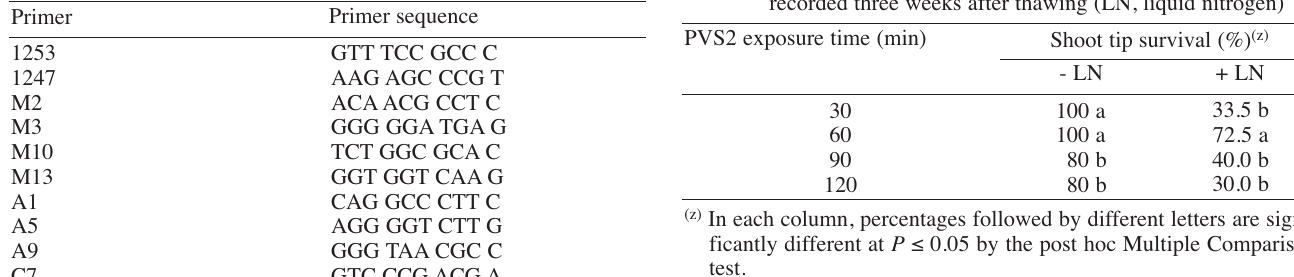
Table 2 - Survival of cryopreserved shoot tips of ‘Rosso di Chioggia’ after exposure to PVS2 for different time periods. Data were recorded three weeks after thawing (LN, liquid nitrogen) PVS2 exposure time (min)